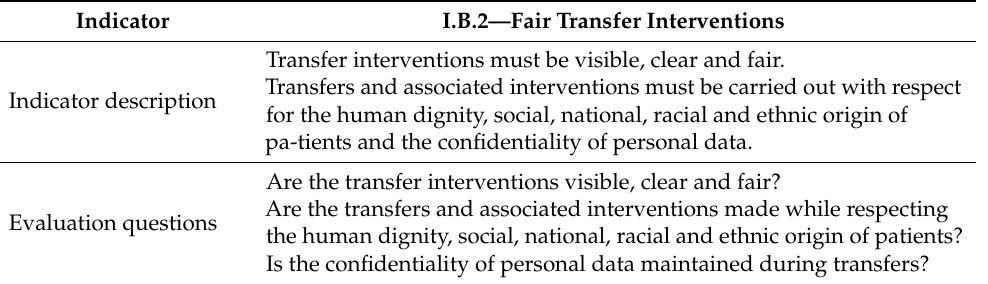
Table 11. The indicatorI.B.2—Fair transfer interventions.